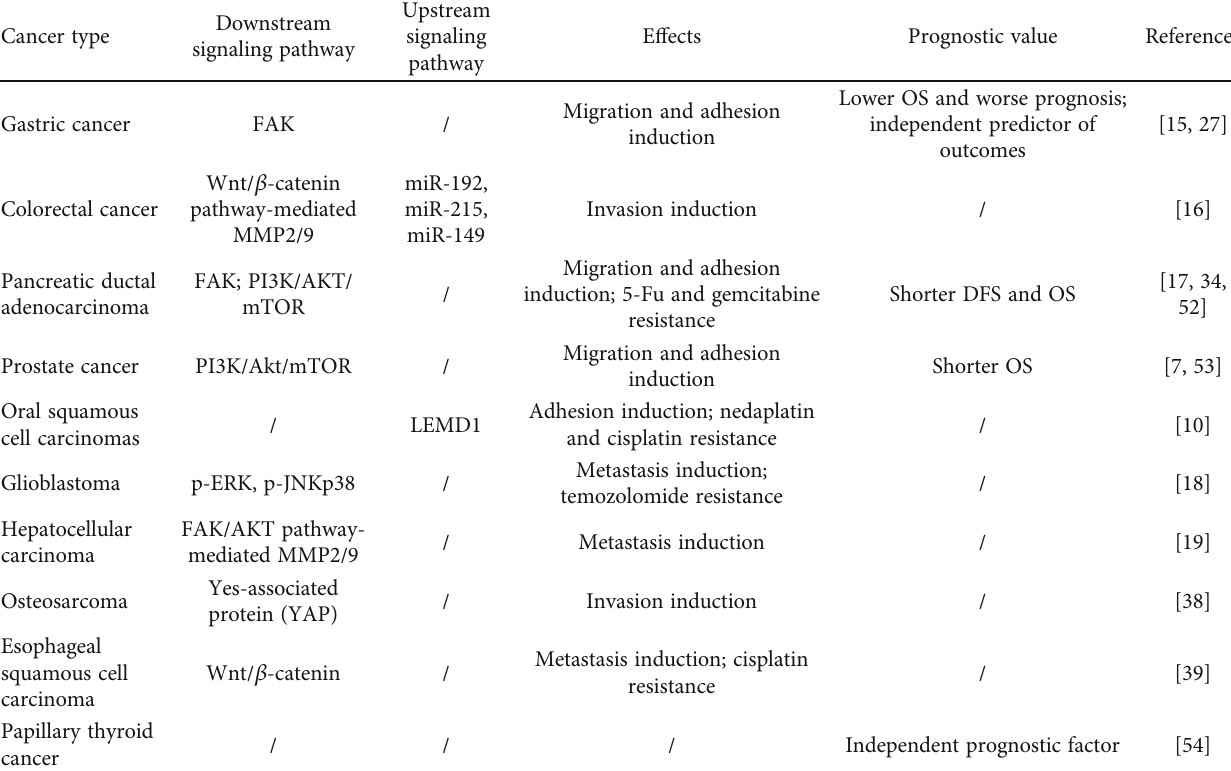
Table 1: Roles for SRPX2 in cancer metastasis, invasion, migration, drug resistance, and prognosis. Cancer